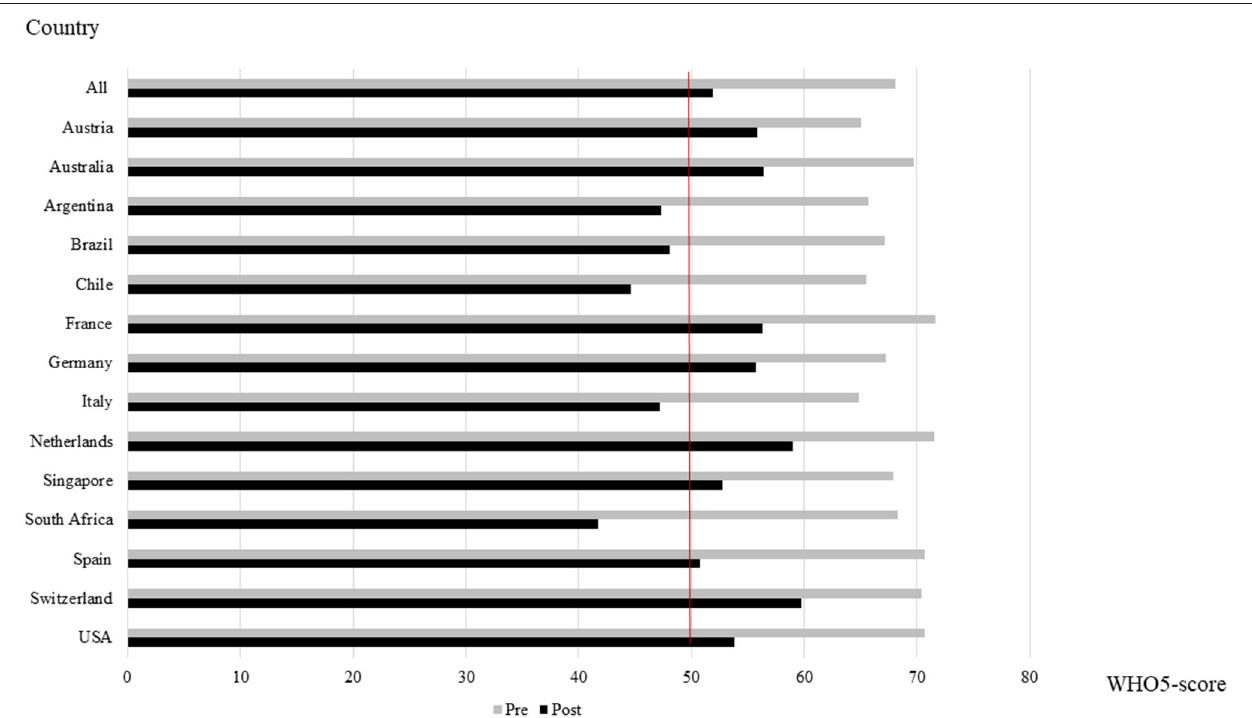
FIGURE 1 | Mental well-being (mean WHO-5 sum score) pre- and during public life restrictions in all included countries. The red line indicates the cutoff score for depression screening (50%).